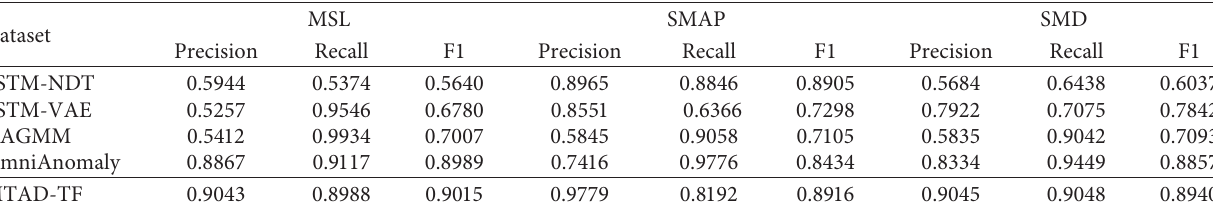
Table 2: Performance of our model and baselines.